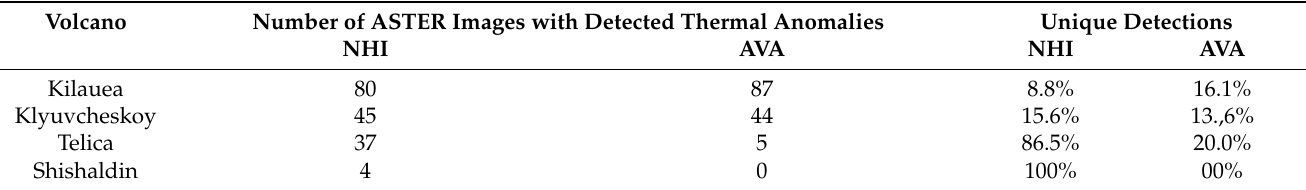
Table 2. NHI and ASTER Volcano Archive (AVA) thermal anomaly detections performed on ASTER data of March 2000–2008 at Kilauea, Klyuvcheskoy, Telica and Shishaldin volcanoes. Volcano Number of ASTER Images with Detected Thermal Anomalies Unique Detections NHI AVA